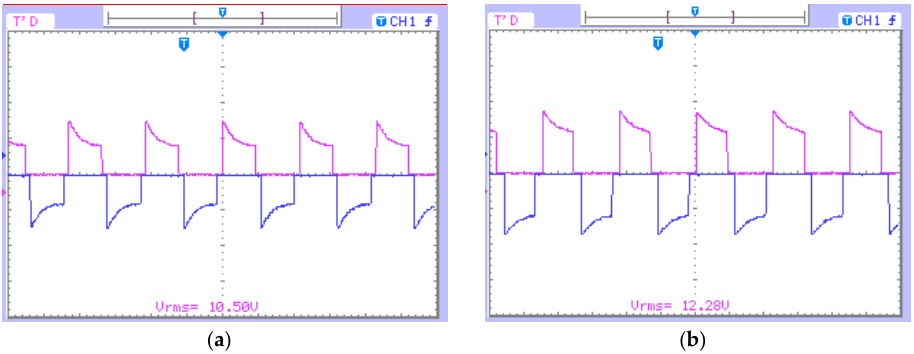
Figure 21. Experimental output voltage waveforms for an input DC voltage of 12 V: ( a ) buck mode inverter output with modulation index (MI) = 0.8; ( b ) boost mode inverter output with MI = 0.8 and ST = 0.1 (Voltage: 10 V/div, Time: 10 ms/div).